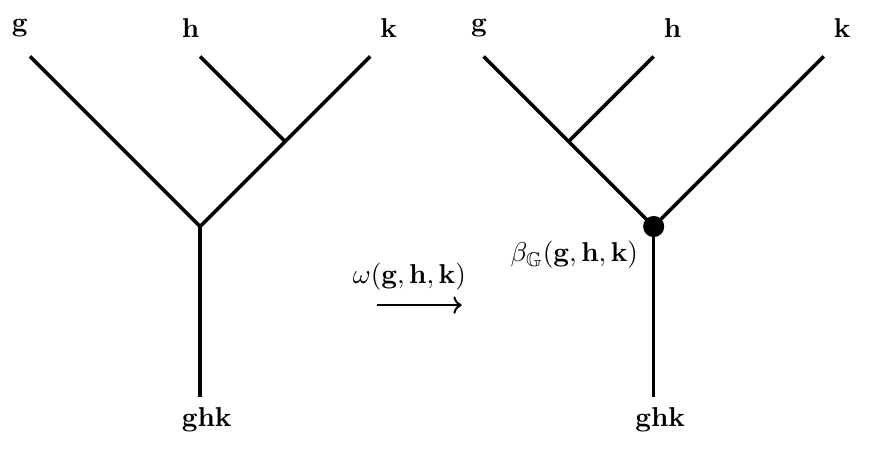
Figure 1 . The point operator appears at the vertex due to implementing an F